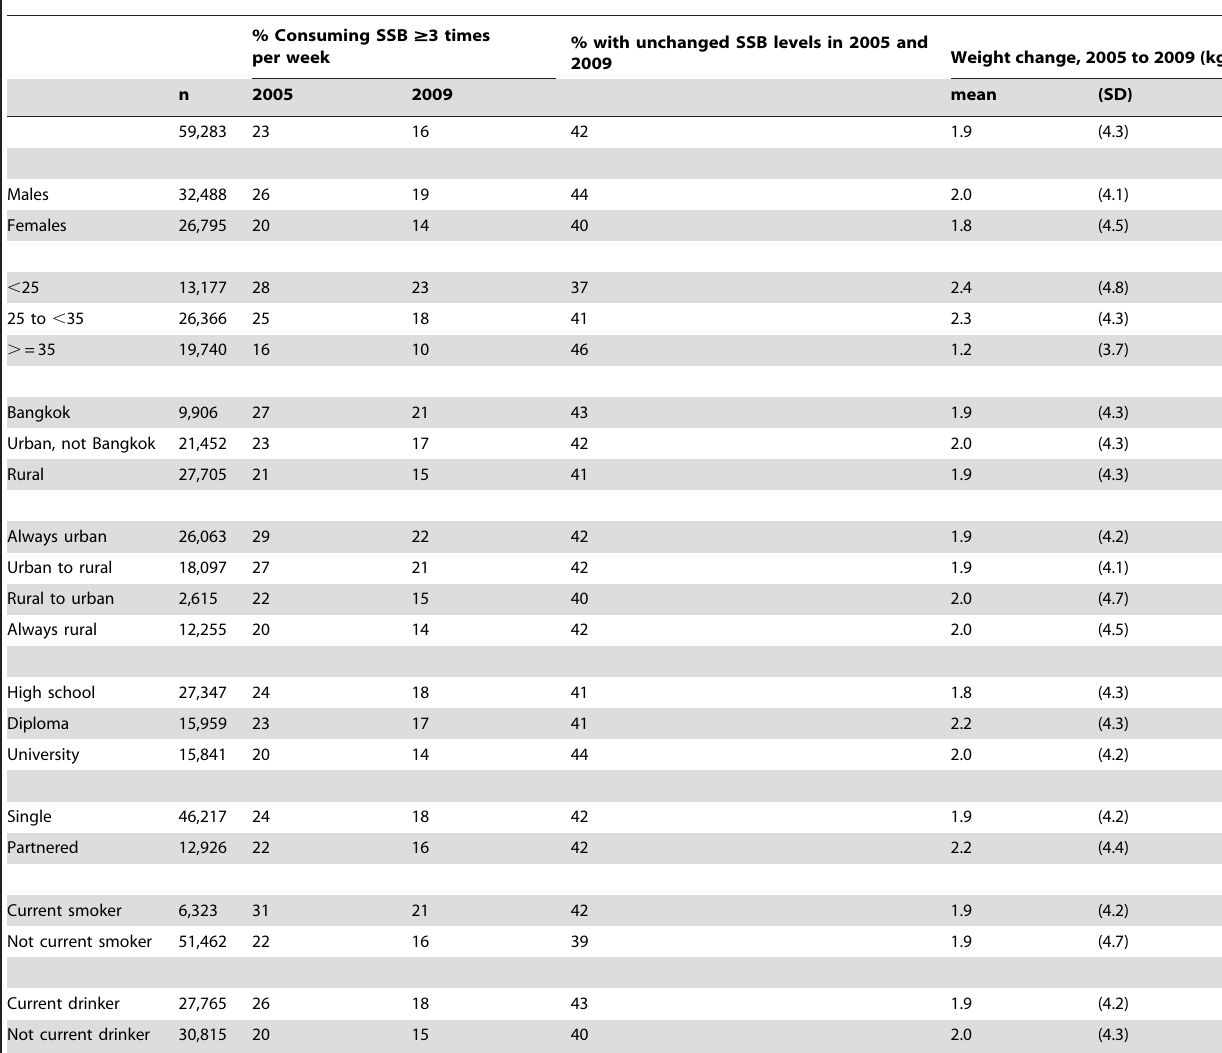
Table 2. Characteristics of those consuming 3 or more SSBs per week and weight change between 2005 and